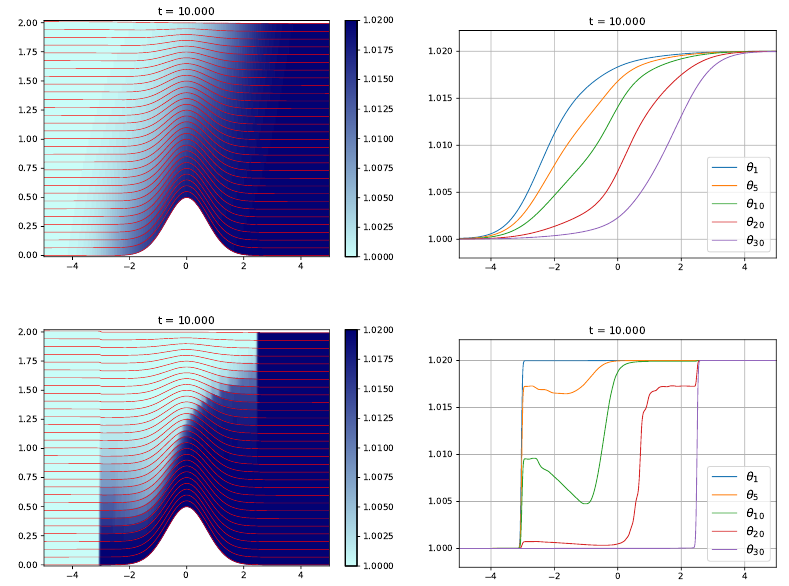
Figure 29. Distribution of the relative density θ . The first row corresponds to the first order scheme and the second row to the second order scheme.